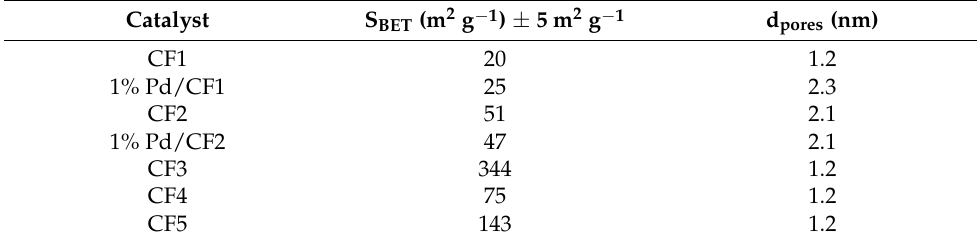
Table 1. Textural properties of the carbon fibers and